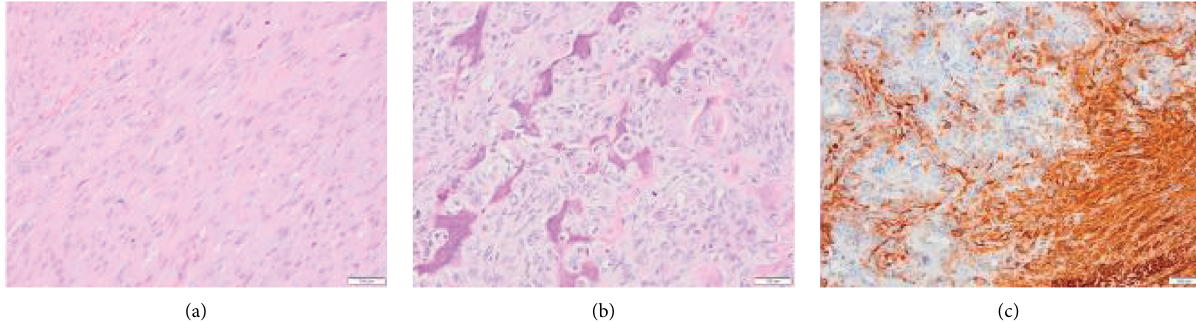
Figure 2: Spindle cell morphology of leiomyosarcoma (a) and dedifferentiated component of tumour characterized by pleomorphic, atypical cell producing osteoid (b) that was immunohistochemically completely negative for smooth muscle actin (SMA, as well as other muscle markers)